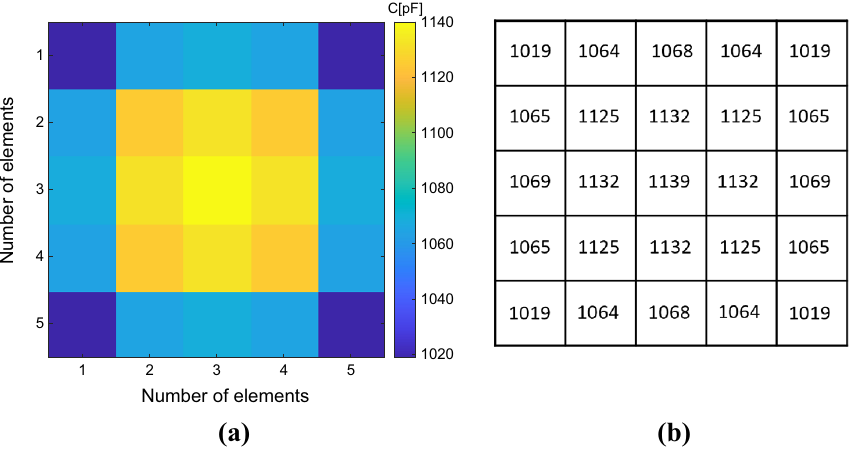
Figure 5. ( a ) Capacitance map calculated through the analytical model previously exposed. The map allows to evaluate the spatial correspondence between each cell of the metasurface and the capacity value required to homogenize its response. ( b ) Capacitance numerical values (pF) used to homogenize the